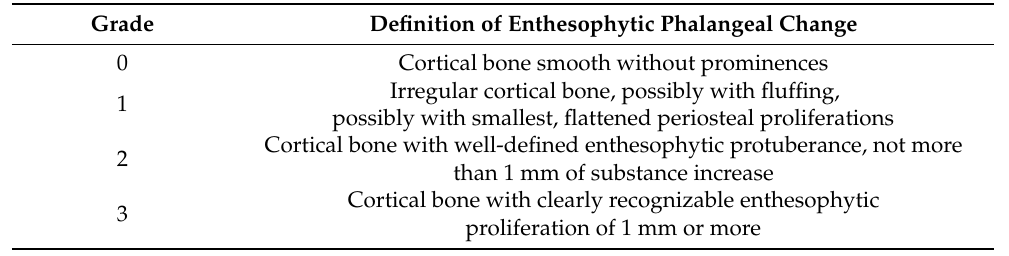
Table 1. Refined definition of enthesophytic growth at digital phalanges, modified from Karasik et al. [12] .